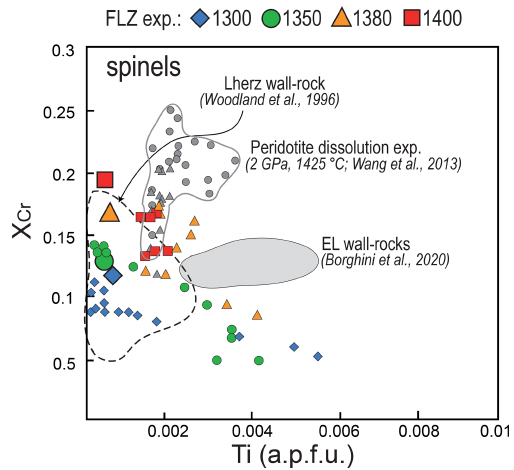
Figure 12. X Cr versus Ti content (a.p.f.u.) variations in spinel from pyroxenite–peridotite experiments from this study compared with those from peridotite dissolution experiments at 2GPa and 1425 ◦ C (Wang et al., 2013). Symbols and references are as in Fig. 11. Also shown are the fields defined by spinel compositions of metasoma- tised wall-rock peridotites from External Liguride mantle sequences (northern Apennines, Italy; Borghini et al., 2020) and pyroxenite- hosting wall-rock peridotite from Lherz ultramafic massif (Pyre- nees, France; Woodland et al.,